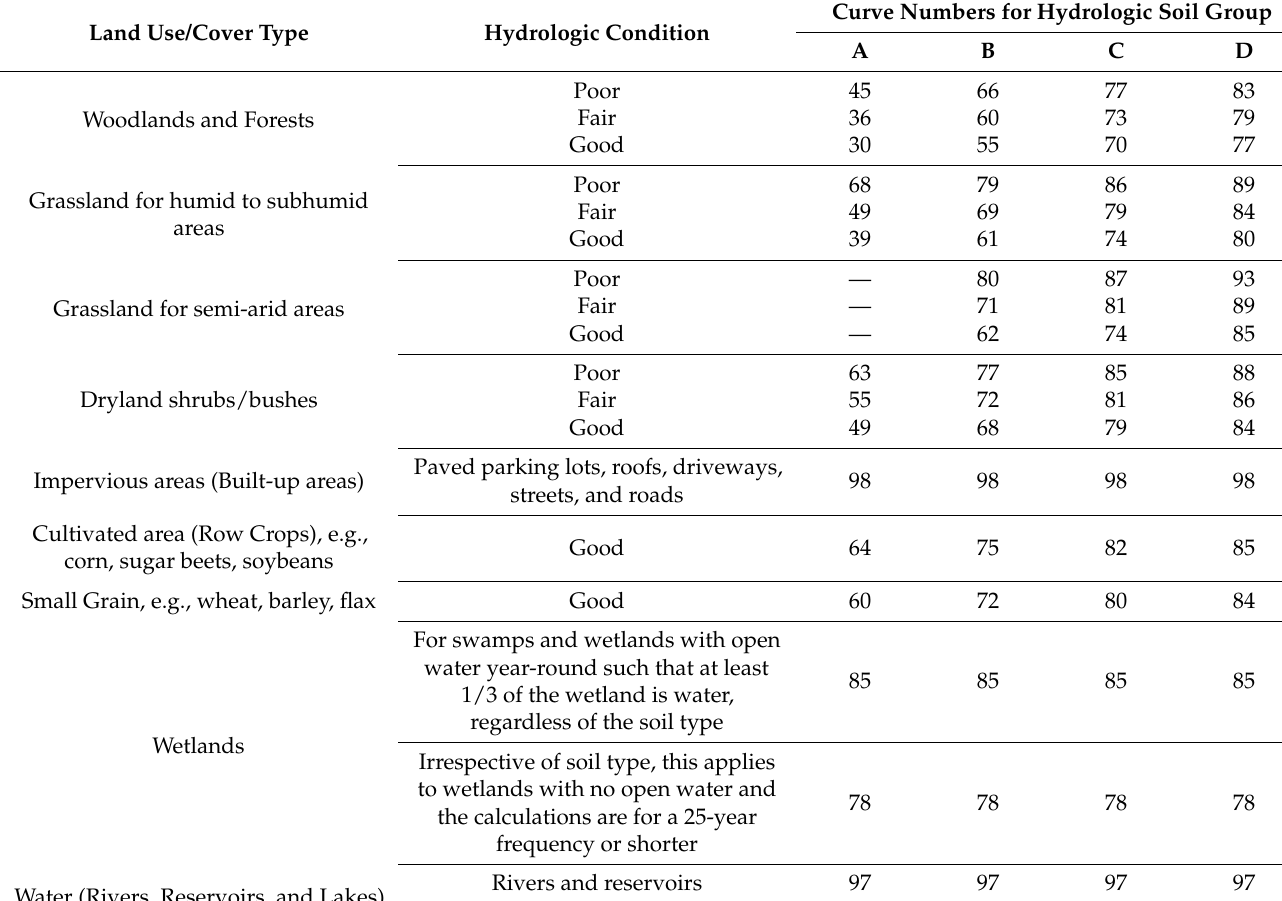
Curve Numbers for Hydrologic Soil